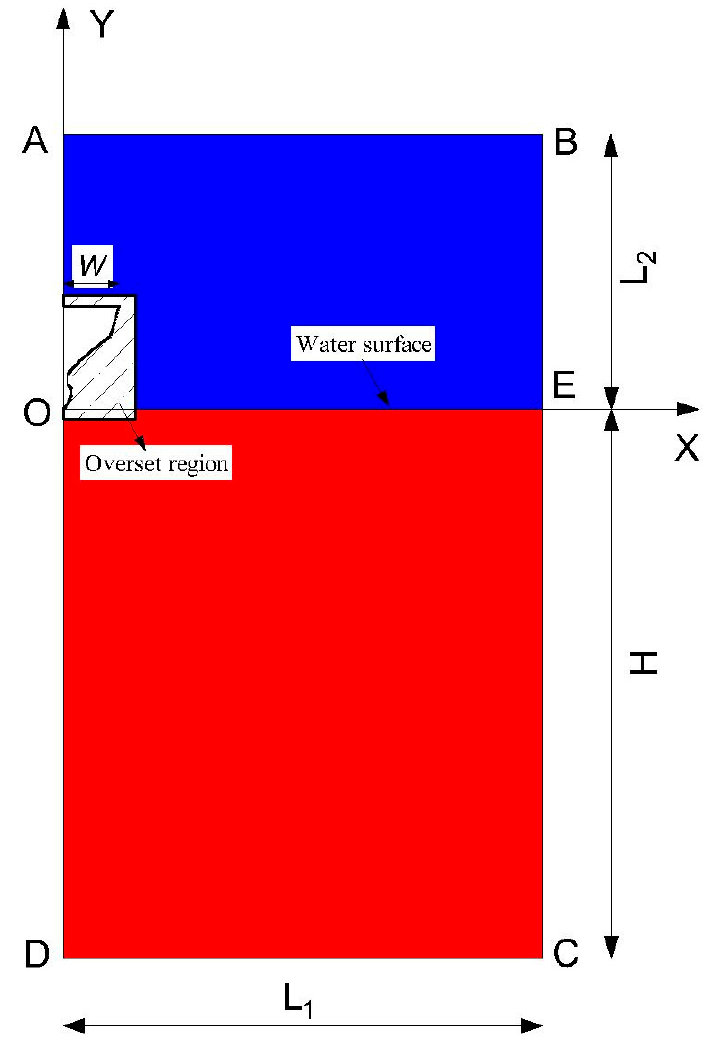
Figure 1. Schematic diagram of the computational domain.